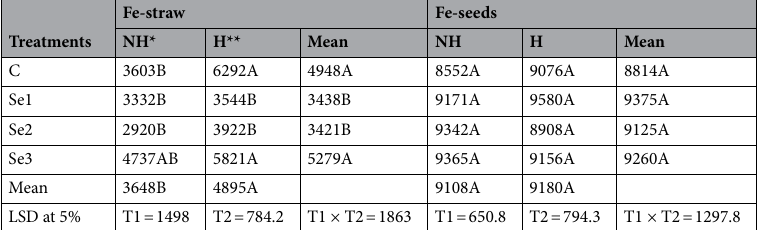
Table 8. Effects of Se and K-humate application on Cr content. *Refers to Se application without K-humate. **Refers to the simultaneous application of Se and K-humate.